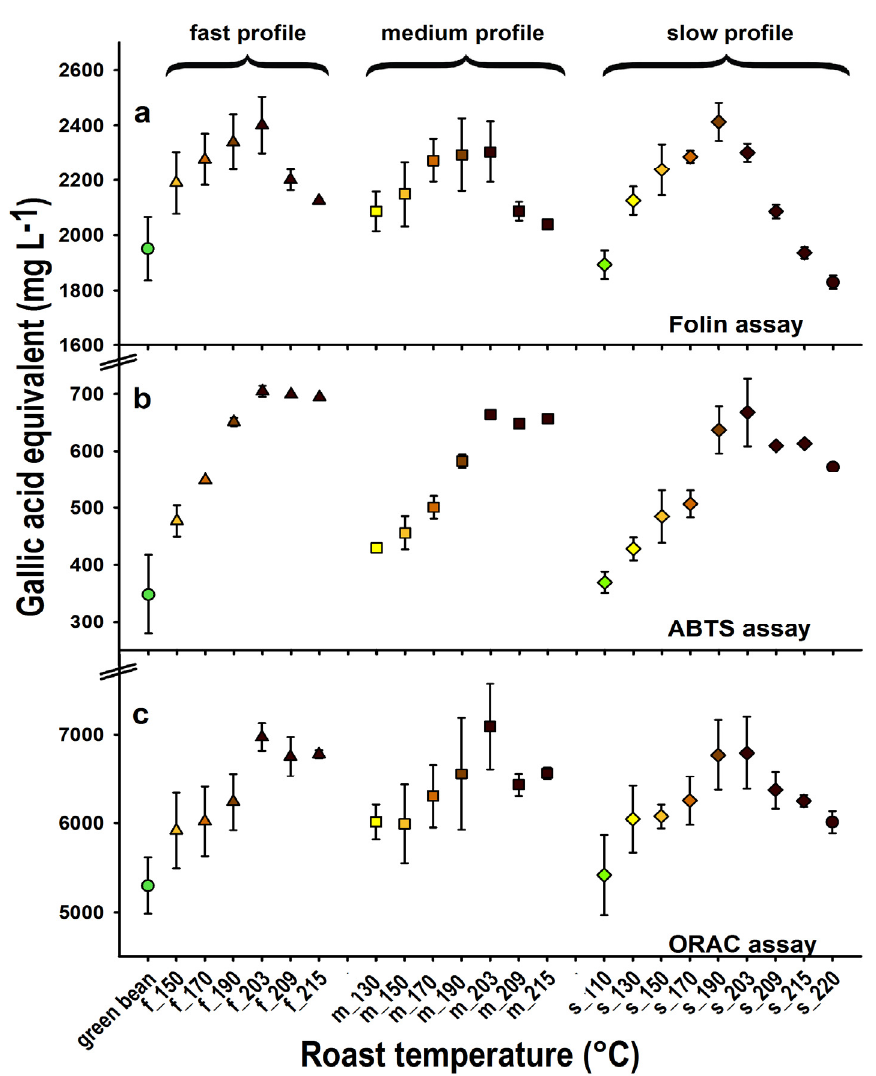
Figure 2. Antioxidant capacity (as gallic acid equivalents, GAE, mean ± SD) of green and roasted coffee measured using ( a ) the Folin-Ciocalteu, ( b ) the ABTS, and ( c ) the ORAC assays. Three roast profiles (fast, f; medium, m and slow, s) were conducted and coffee beans were removed at the given temperatures. The values are depicted with colors from green to brown with increasing roast degree; six roast degrees for the fast profile, seven for the medium profile, and nine for the slow profile were roasted (roast replicate n = 2, except for the higher roast temperatures 209, 215, 220 °C, which were only roasted once (brewing replicates n =